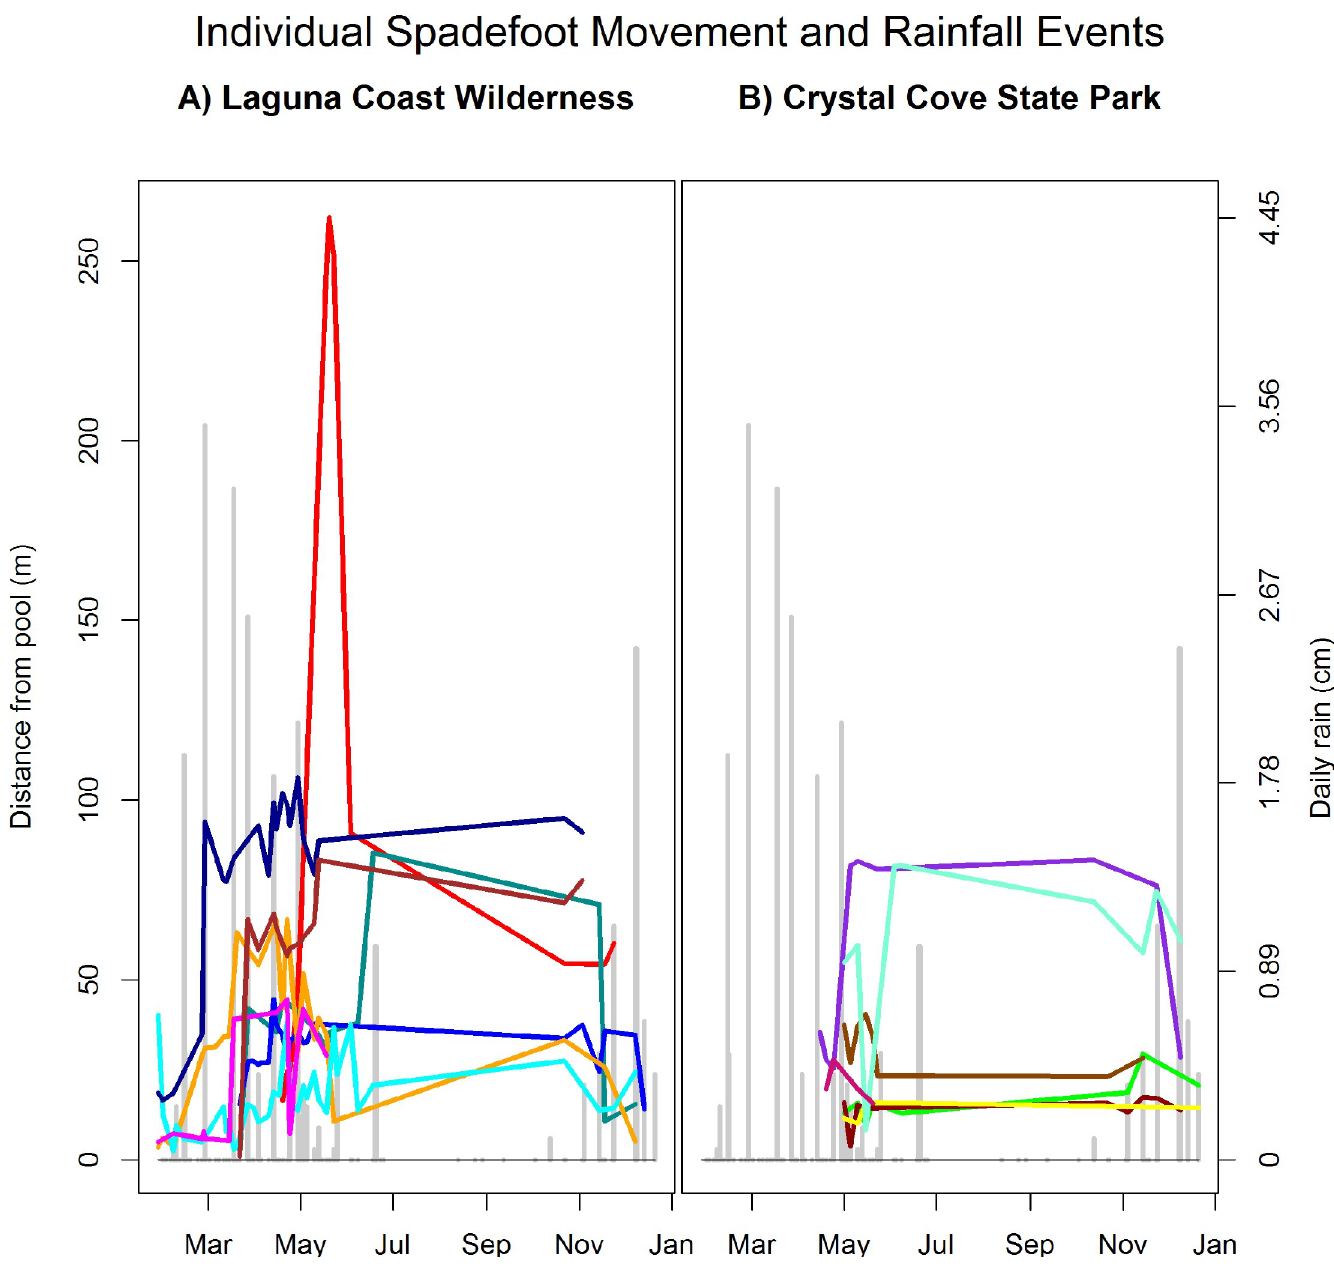
Fig 2. Spadefoot movement away from breeding pools vs. rainfall. Spadefoot movement away from breeding pools over the course of the study (January 2012 through January 2013) at A) Laguna Coast Wilderness and B) Crystal Cove State Park. Daily rainfall in Orange County, USA, is displayed in gray bars in the background, and each line represents an individual spadefoot’s distance from the breeding pool throughout the year. Most individuals remained within 100 m radial distance from the breeding pool, while one individual went much farther. Movements occurred outside rainfall events, and movement did not always occur during rainfall events, but statistically the relationship is significant (see Table 3). Individuals were tracked for a shorter time period at Crystal Cove State